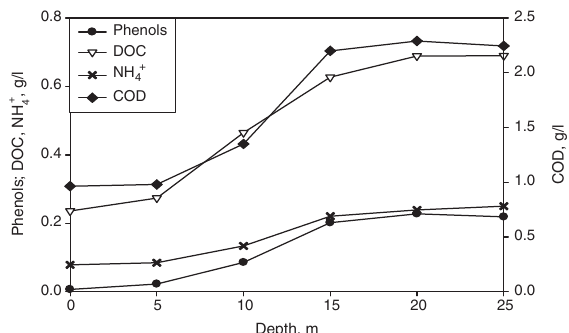
Fig. 1. Analytical data of the disposal pond water depending on the depth before remediation (Wießner et al.